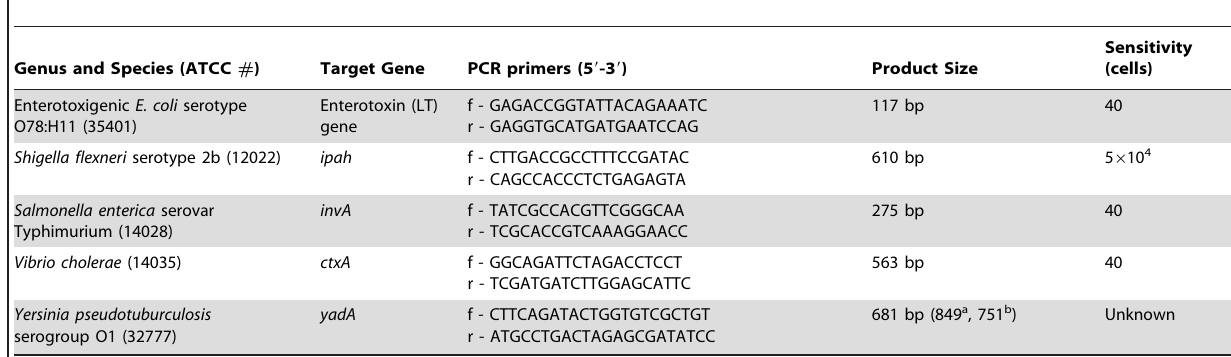
Table 1. Bacterial strains (positive controls), target genes, and primers* used in this study.